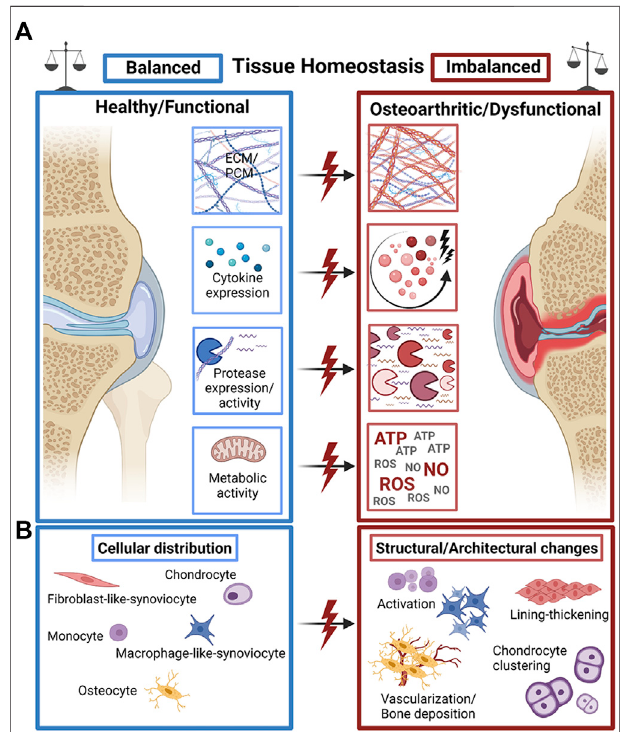
FIGURE 1 | The fi ne line of tissue homeostasis in OA. (A) A plethora of structuraland biochemical tissue factors such asextra-and pericellular matrix (ECM/PCM) biosynthesis, cytokine expression, protease expression and metabolic activity of cells guide the dysfunctional progression of OA joint tissues. (B) Changes in the distribution, occurrence, and activity of a variety of tissue-speci fi ccell types mediatethe structuraldecline ofOA jointtissues with characteristic pathophysiological cell activation and proliferation, synovial lining thickening, and cell clone formation/clustering as well as pathological hypervascularization and bone deposition (calci fi cation). Created with permissions from Biorender.com.